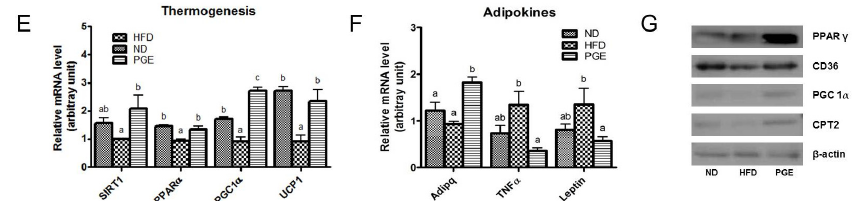
Figure 2. Effects of PGE on body fat mass, energy expenditure, and mRNA expression of adipogenic and thermogenic genes via regulation of fatty acid oxidation in epididymal white adipose tissue in HFD ‐ fed C57BL/6J mice. The data are the mean ± SEM ( n = 10). ( A ) The weight of adipose tissue; ( B ) representative photographs of adipocytes in the epididymal WAT of the mice, 200× magnification; and ( C ) energy expenditure and oxygen consumption ( V o 2 ). Adipogenesis ( D ); thermogenesis ( E ); and adipokine ( F ) related gene expression. ( G ) Western blot analysis of β‐ actin, PPAR γ , CD36, PGC1 α , and CPT2 expression. ND, mice fed a normal diet; HFD, mice fed a high ‐ fat diet (HFD) alone; PGE, Platycodon grandiflorus root extract (5%, w / w ) ‐ treated HFD ‐ fed mice; WAT, white adipose tissue.